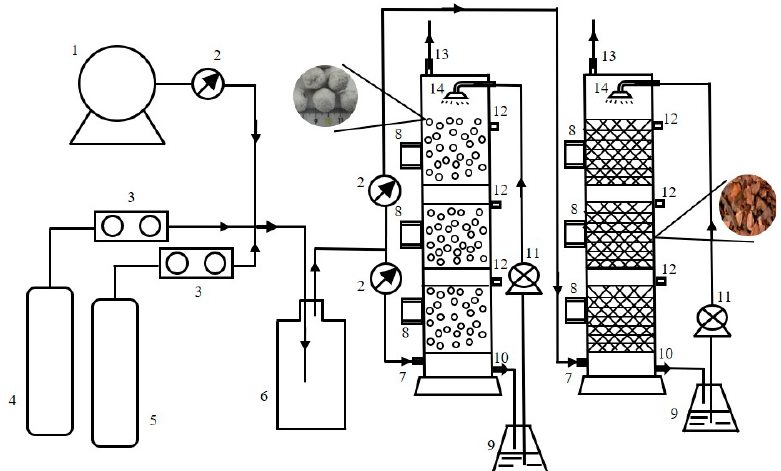
Figure 1. Schematic of biotrickling filter. (1) Air pump, (2) Rotameter, (3) Mass flowmeter, (4) H 2 S cylinder, (5) NH 3 cylinder, (6) Gas mixing cylinder, (7) Air inlet, (8) Filler sampling port, (9) Circulating fluid, (10) Circulating fluid outlet, (11) Peristaltic pump, (12) Gas sampling port, (13) Gas outlet, (14) Sprinkler head.